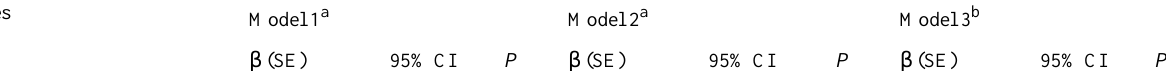
Table 5. Linear regression: association between online health information–seeking behaviors and physical